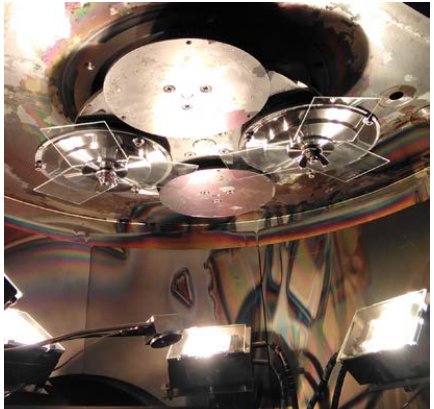
Figure 2. E-beam deposition system: glass substrates mounted on the rotating planetary. The thick- ness monitor sensor is also